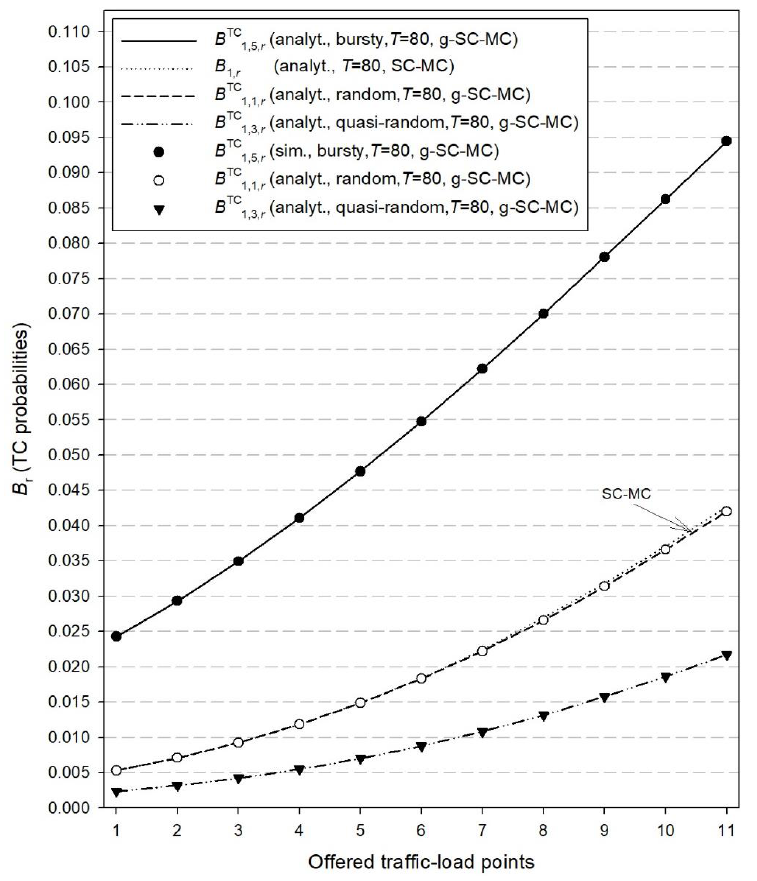
Figure 2. TC probabilities ( TC